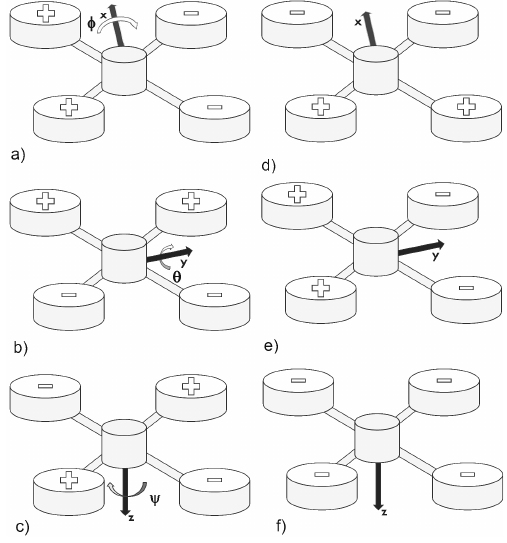
Figure 3. Rotation around the axis x , y , z about Roll ( a ), Pitch ( b ) and Yaw ( c ) angle and translations along x ( d ), y ( e ), z ( f ) axis through the increase (+) and/or reduction ( − ) of rotational speed of coaxial propulsion units (pairs: one above the other).